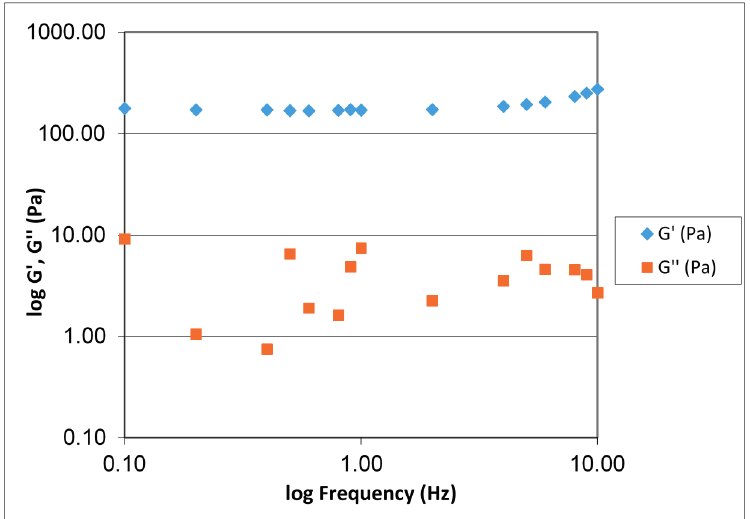
Figure 5. Frequency sweep for a 1.0% ( w / w ) V3D2 gel at 3% theoretical